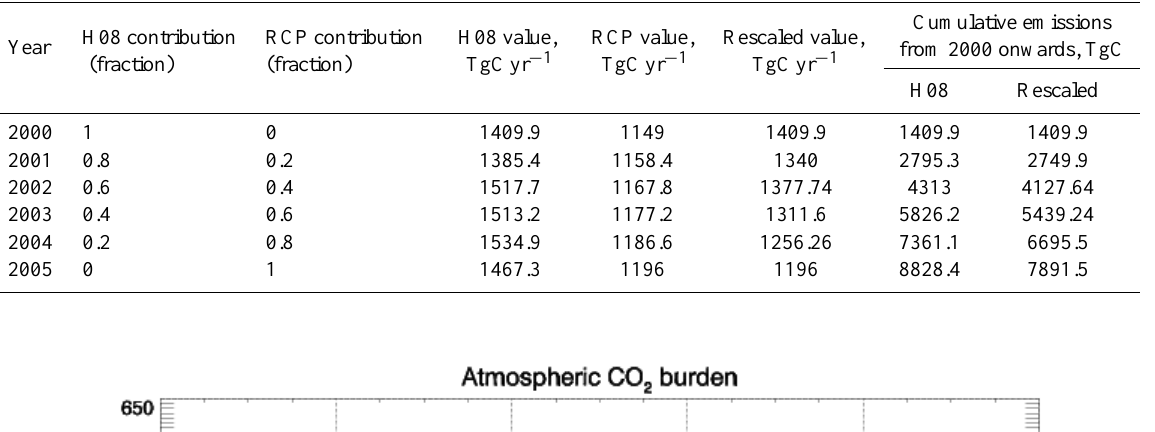
Table 2. Definition of the manner in which the Houghton (2008) land use emissions data (H08) and RCP data were combined in years 2000 to 2005. The last two columns show how the cumulative emissions from the original H08 data compare with those of the rescaled data, the latter being 0.94GtC lower over the period considered.